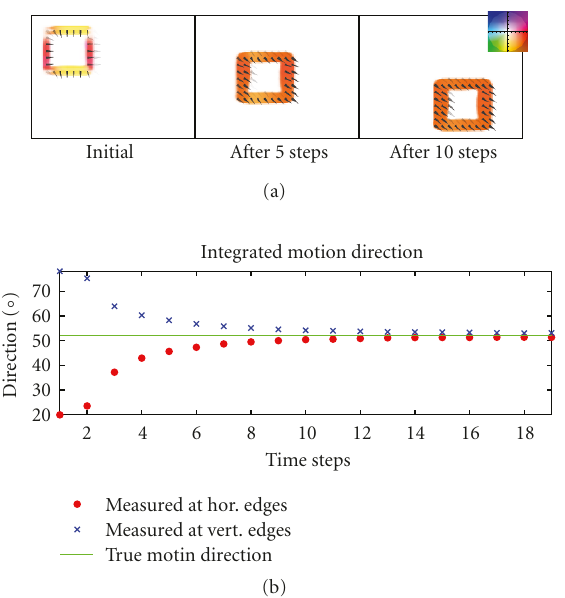
Figure 6: This example shows a moving square with elongated boundaries and homogeneous surface layout (image size is 320 × 240 pixels). Motion direction is 38.7 ◦ in clockwise direction measured against the horizontal axis (down-right) at a speed of ( Δ x , Δ y ) = (4 . 0,5 . 0)px/frame. Image frames have been lowpass filtered to avoid aliasing. Motion correspondences are tested in the range of Δ = ± 7 px/frame along the horizontal and vertical directions, respectively. The local average motion activity is displayed by a vector and a color code presented in the palette on the right. The true motion direction can only be measured initially (first frame) at the four corners while along the 1D edges only the normal flow components orthogonal to the contrasts are detected (aperture problem). Feedforward and feedback interactions between model areas V1 and MT ensure that the true object motion signals are integrated and further propagated along the outline boundary of the object to disambiguate locally ambiguous estimates (see second and third frames on the top). The initial direction error decreases over time until the true object motion is achieved at all parts of the object and a coherent motion representation has been built over time. The temporal resolution of the aperture problem has been measured in neurophysiological experiments [41] and demonstrates that MT cells adapt to the true velocity over time, just as in these